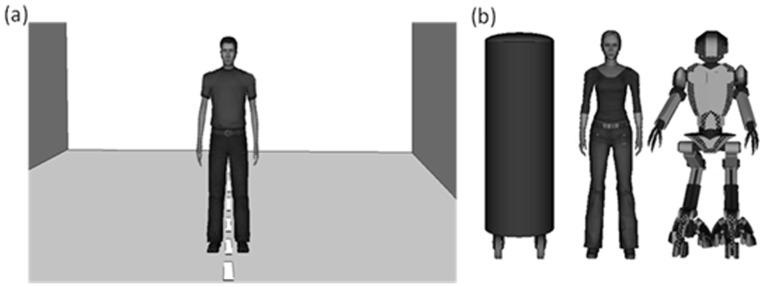
Virtual stimuli and environment.Panel (a) shows participant’s perspective when a virtual agent (e.g., an adult male) frontally appeared. A straight dashed white line placed on the floor traced the path that participants and virtual agents followed during both approach-conditions. Panel (b) shows (from the left) the other virtual stimuli used: a cylinder, an adult woman, and an antrophomorphic-robot.